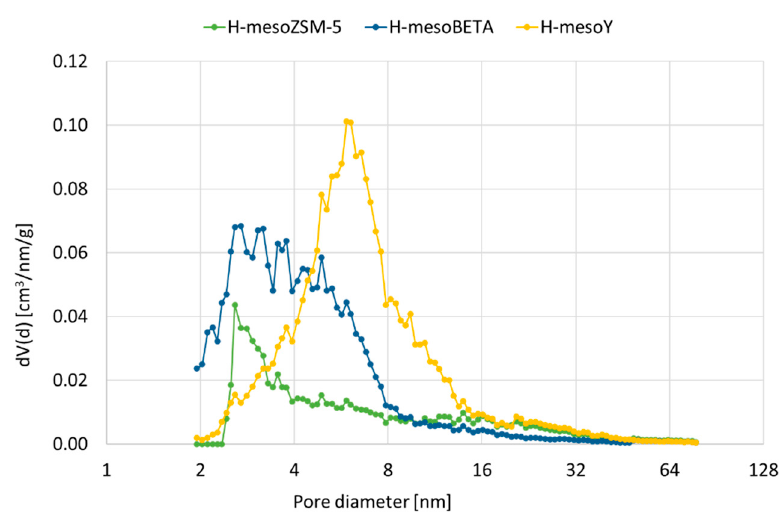
Figure 1. Pore size distribution for treated zeolites H-mesoZSM-5, H-mesoBETA and H-mesoY.